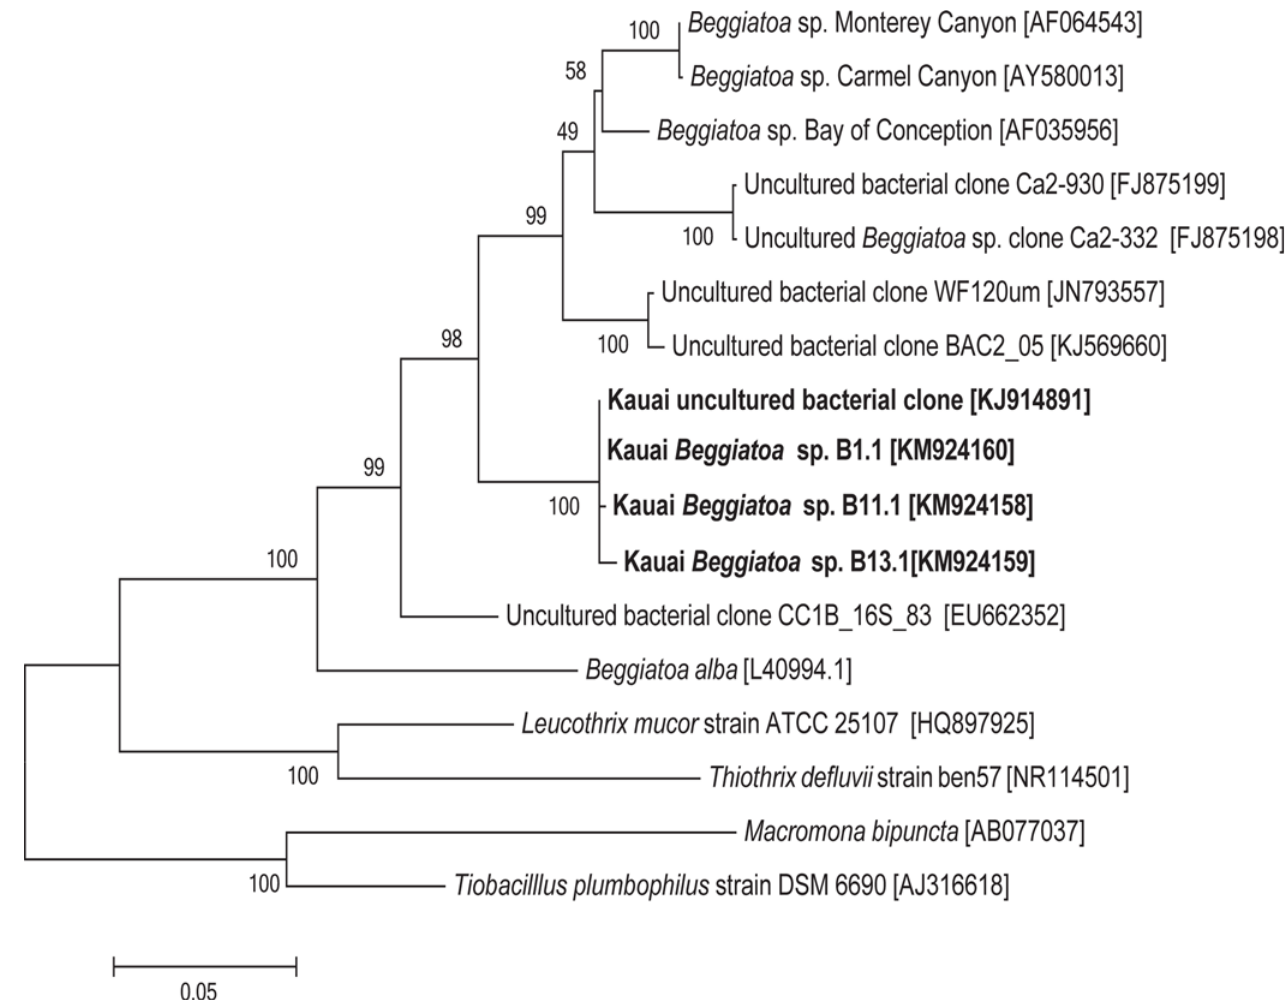
Fig 6. Phylogenetic relationship of Beggiatoa spp. isolated from disease lesions from Kaua ‘ i to other Beggiatoa . A phylogenetic tree was generated using the Maximum Likelihood method with sequences from 14 other Beggiatoa and closely related sulfur-oxidizing strains including representative type strains from the Thiotrichaceae family. No 16S rRNA gene sequences from Beggiatoa found in BBD from other regions were available for comparison. The tree with the highest log likelihood is shown, and 1000 bootstrap replicates were used. NCBI accession numbers are in brackets, and bootstrap values are indicated at branch nodes. Scale bar represents five substitutions per 100 nucleotide